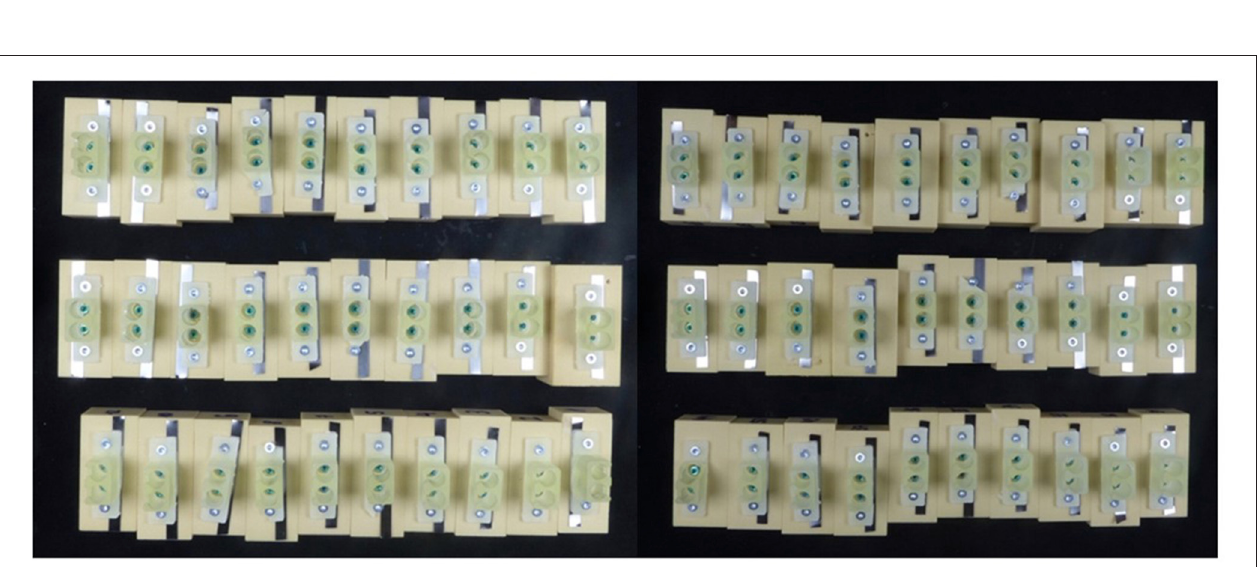
FIGURE 3 | Three different materials (white resin, dental LT clear resin, dental SG resin: Formlabs) were printed, cured (Formcure UV, Formlabs, 60 ◦ C, 20min), and then autoclaved (Vakuclav 41B, Melag, 135 ◦ C, 18.23min).